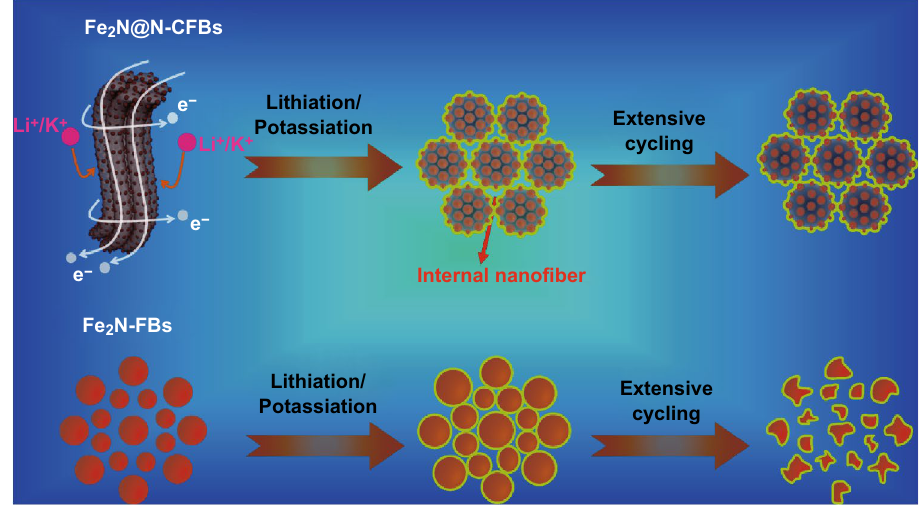
Fig. 7 Schematic of the different structural evolutions of the Fe 2 N@N-CFBs (top panel) and Fe 2 N-FBs (bottom panel) electrode materials dur- ing the electrochemical lithium/potassium storage reaction. The light-yellow layer coating on the surface represents the SEI film. (Color figure